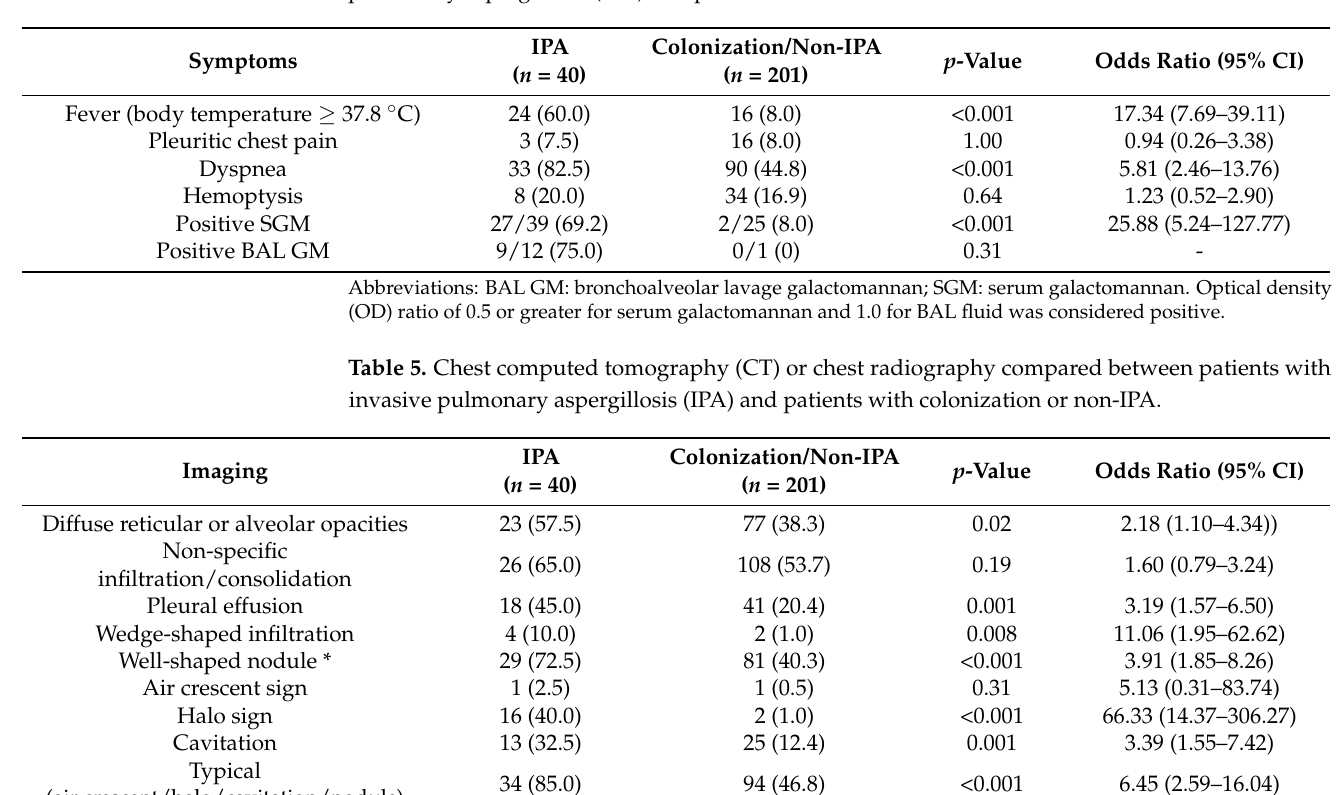
Table 4. Clinical manifestations and galactomannan level compared between patients with invasive pulmonary aspergillosis (IPA) and patients with colonization or non-IPA.